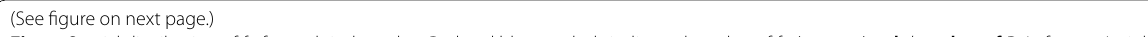
figure on next Fig. 7 Spatial distribution of f lp for each index value. Red and blue symbols indicate the value of f lp (see text). a , b b ; c , d η ; e , f D . Left, area A; right, area B. The epicenters of the large earthquakes ( M 6.1 in area A, M 7.0 in area B) are also plotted in a and b . Green contours in b , d , and f indicate ≥ ≥ the surface-projected coseismic slip of 10 m of the Tohoku-oki earthquake (Suito et al. 2012). Activity in regions of low p -values (red or blue) indicated by arrows is discussed in the